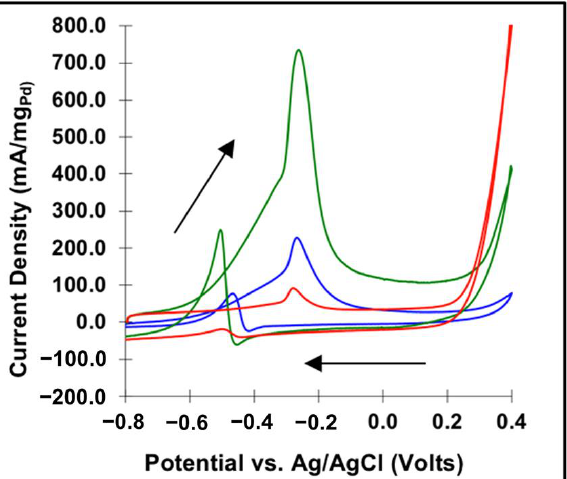
Figure 7. Cyclic voltammogram of 9.5% (PdW) 2 C (green), 5.5% PdMoC (blue), and 10.5% Pd/C (red) in 1 M MeOH/1 M KOH.